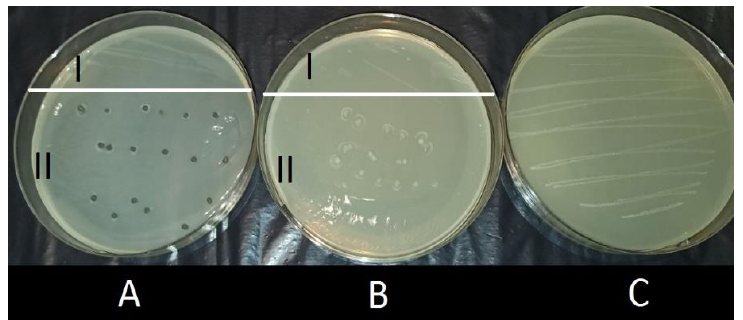
Figure 7. Effect of growth inhibition of E.faecalis by AMOX—a reduction culture (37 °C, 72 h). ( A ) GO-AMOX + BROM alginate capsules (1:2 mg GO /mL Alginate , m AMOX /m GO = 0.18, C E = 0.2 mg/mL Alginate ); ( B ) Alginate capsules with AMOX (C AMOX = 0.09 mg/mL Alginate ); ( C ) Control.